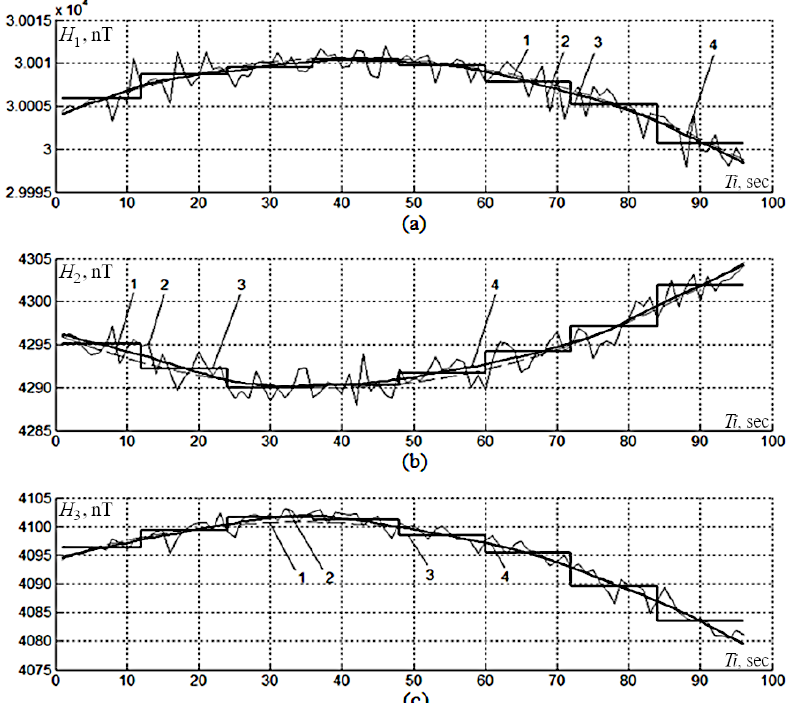
Figure 1. Results of testing the processing algorithm on model measurement data: 1 – initial model functions, 2 – noised model functions, 3 – first-stage result (piecewise-constant model estimates without sliding), and 4 – second-stage result (estimates with weighted averaging).